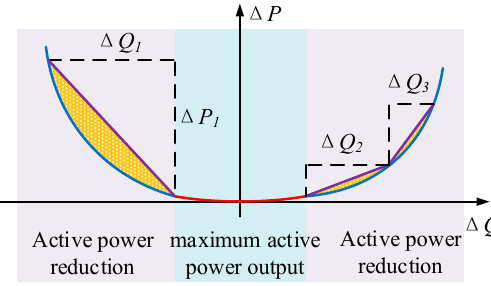
Figure 4. Schematic diagram of the curve showing the relationship of reactive power and active power change that the DPS obtained from the TPS.